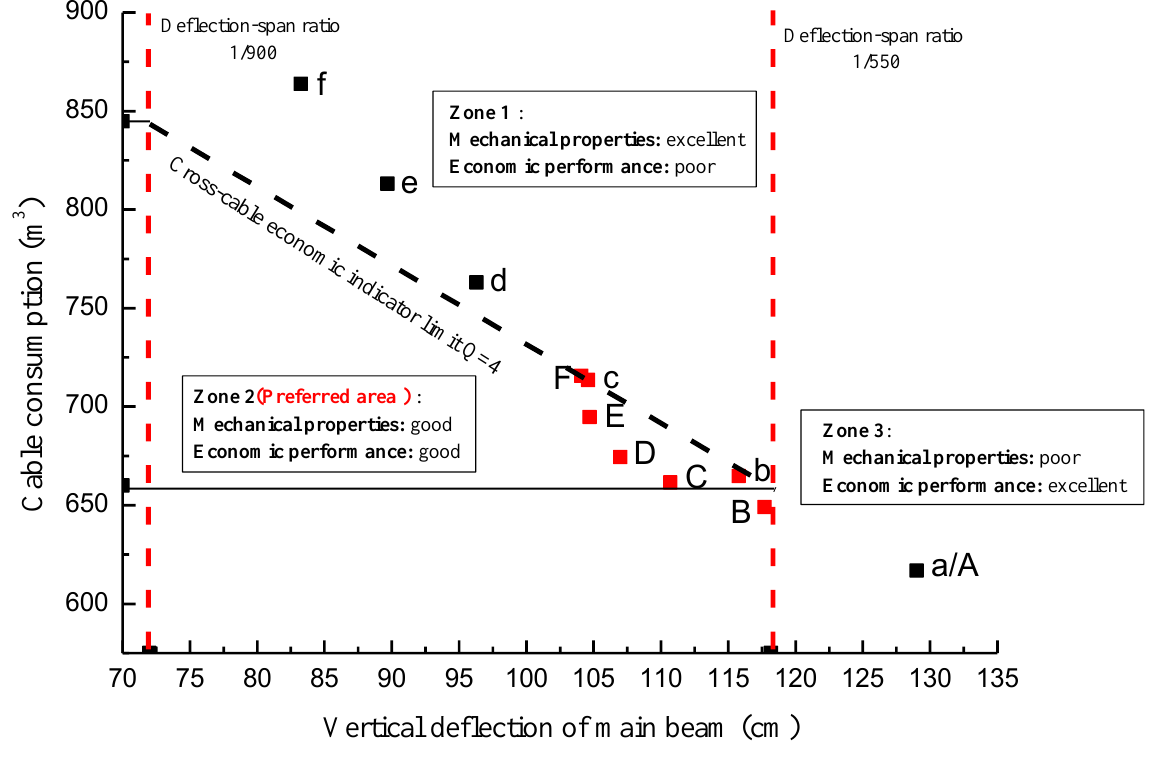
Figure 12. Scheme comparison chart. Figure 12 is the scheme comparison chart on the double indicators. The area in the figure is divided into three areas by the deflection-span ratio boundary and the cable economic indicator boundary.